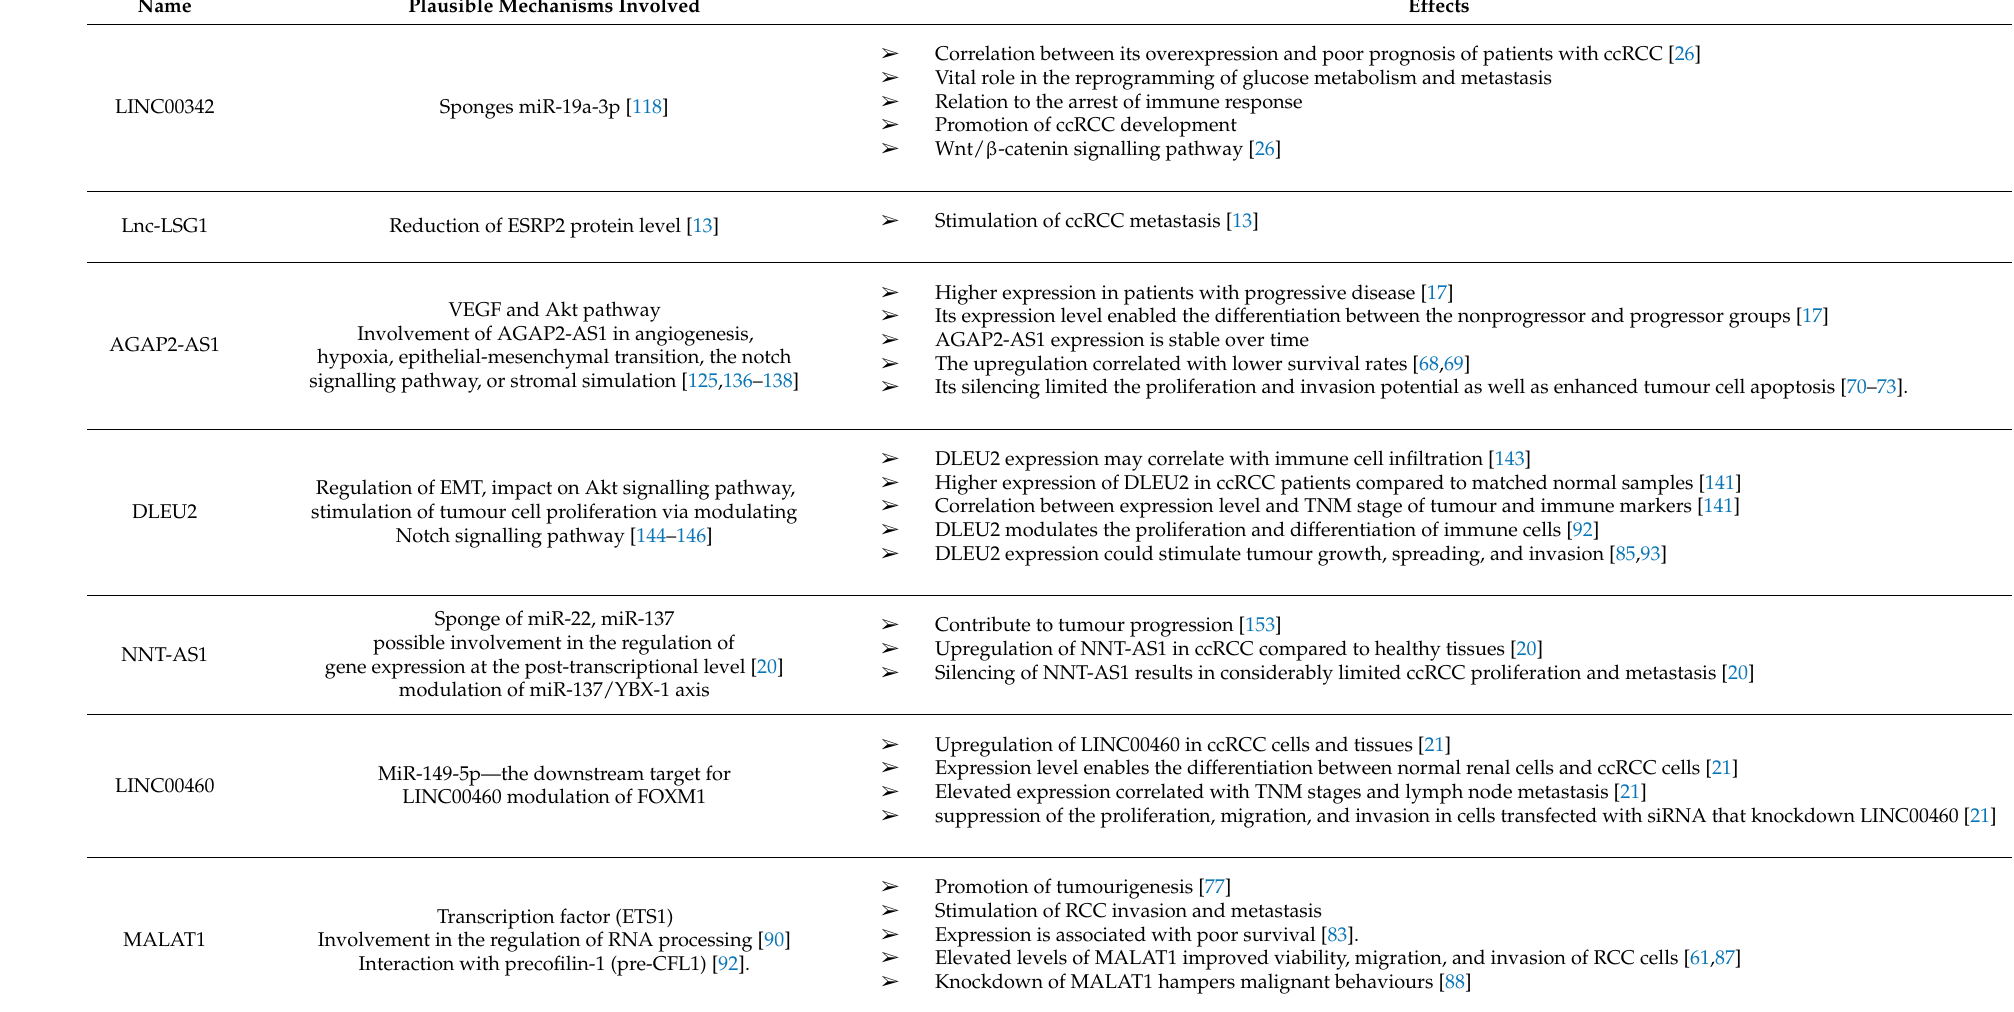
Table 1. Possible role of lncRNA in the progression of ccRCC cancer and